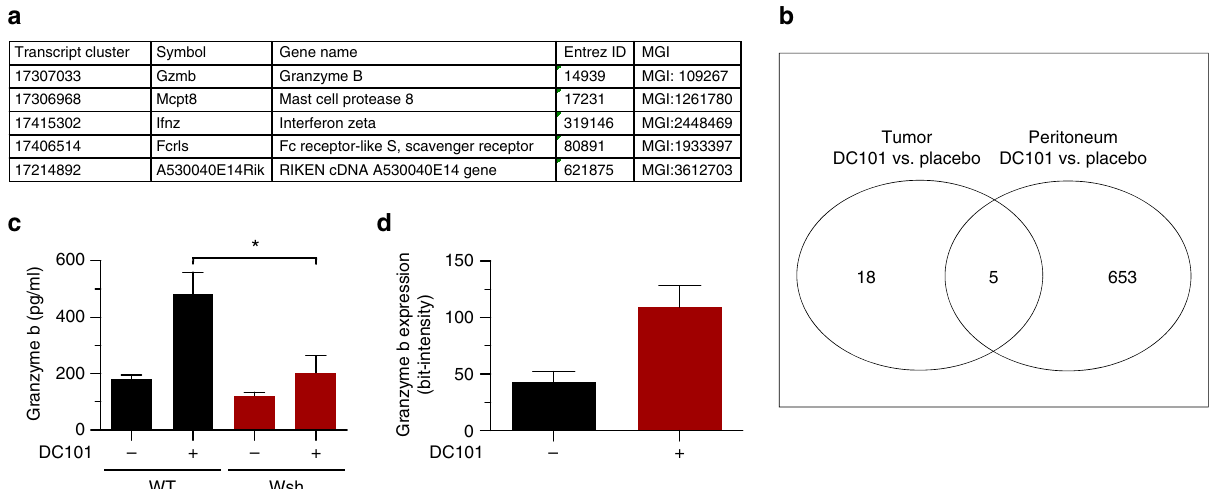
Fig. 3 Mast cell-derived granzyme b is upregulated upon AAT. Panc02 cells were transplanted into the fl anks of C57Bl/6J mice and animals were treated with placebo or 40 mg/kg DC101. Tumor resident MC were sorted from treated and untreated end-stage tumors as well as from the peritoneal cavity of mice. a Differentially regulated genes that overlap in all comparisons. b Venn diagram showing the overlap of regulated genes (* p < 0.05; f -test). c ELISA measuring mouse granzyme b levels in tumor lysates ( n = 5/5/5/5; * p < 0.05; one-way ANOVA). d Histomorphometric quanti fi cation of GZMB signal intensities in tryptase + tumor resident MC. Results are shown for C57Bl/6J mice transplanted with Panc02 tumors that were treated with placebo or 20 mg/kg DC101 ( n = 8/8; * p < 0.05; two-tailed t -test). Results are shown as representative means ±